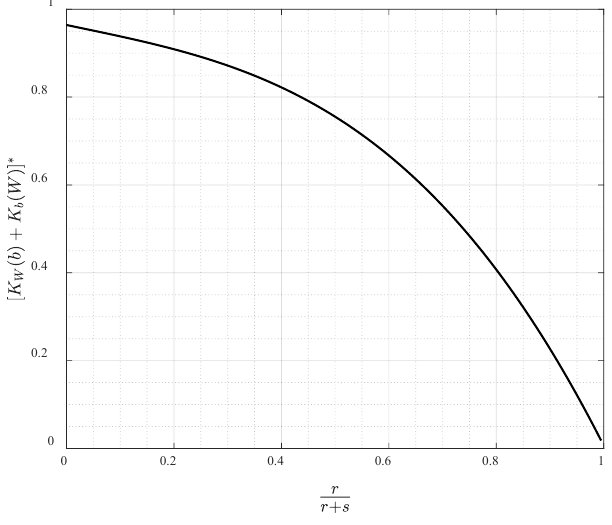
Figure 5. Stern control surface—stability loss due to fins at the tail end of hulls with respect to the full-span equivalent wing [29].